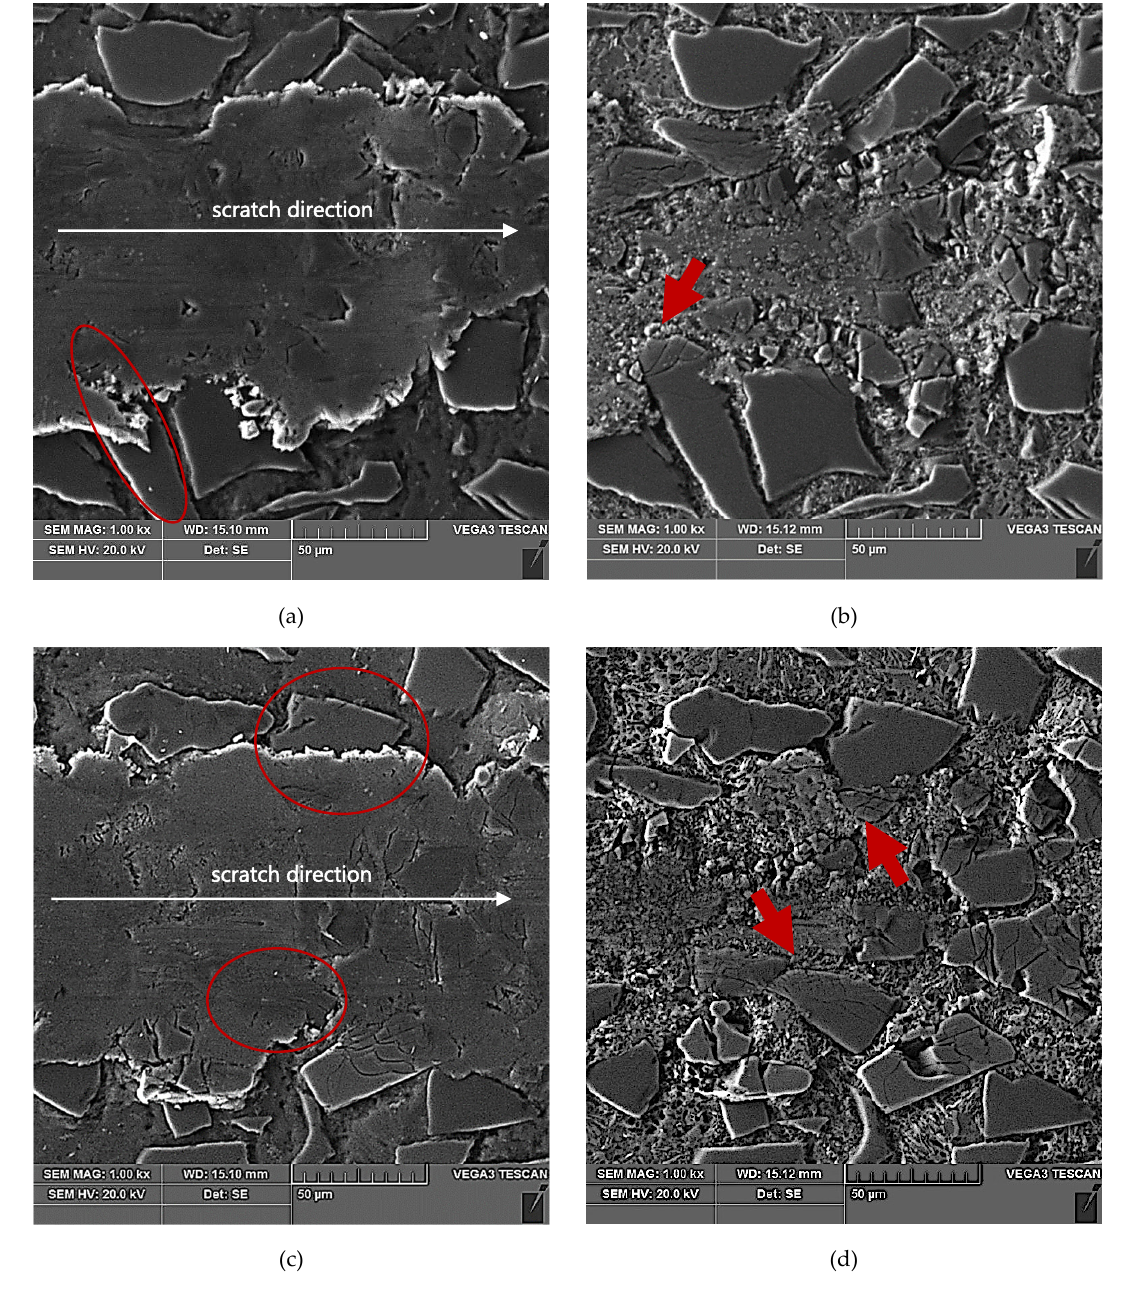
Figure 13. SEM images of a scratch made by the diamond indenter loaded with a force of 10 N in the AlSi12/SiC p composite layer area: ( a ) and ( c ) matrix smearing and particles cracking are visible; section etched with 20% NaOH solution for 2 s; ( b ) and ( d ) degradation of the SiC particles situated on the scratch edge have been marked with red arrows; section etched with 20% NaOH solution for 60 s (deep etching).